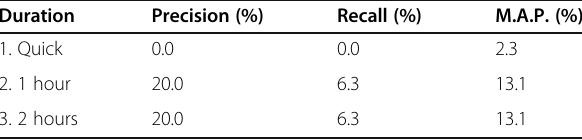
Table 3 The “ Performance Per Tag ” of 3 different durations of training with a 160 lesion dataset Duration